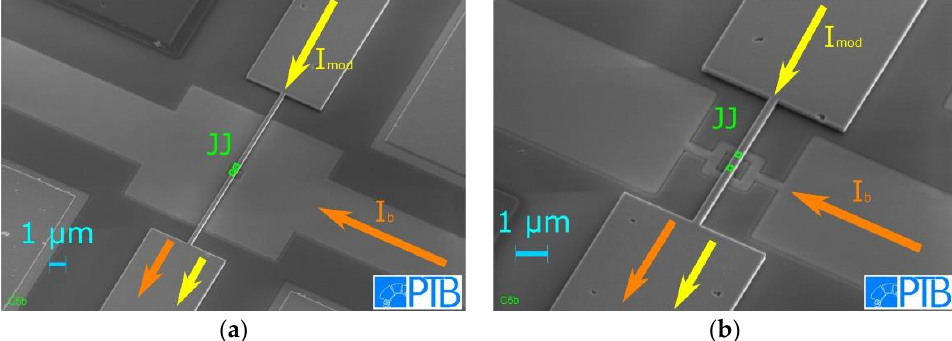
Figure 11. SEM images of both types of fabricated dc SQUID parallel gradiometers, ( a ) SQ-1 and ( b ) SQ-2 after the fabrication of the Nb wiring 1 layer. A closed superconducting loop in the Nb base layer is connected via two JJs to a modulation line in the Nb wiring 1 layer. The bias current I b , and the modulation current I mod are indicated by arrows and the positions of the JJs are indicated by squares. The voltage across the SQUID is measured between the bias current terminals.